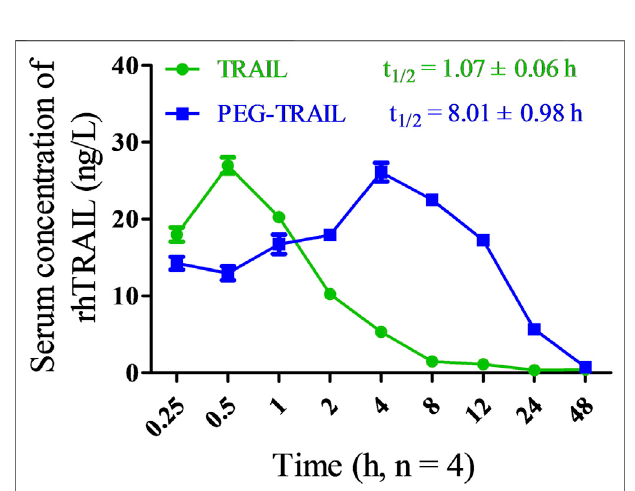
FIGURE 3 | Serum concentrations of rhTRAIL at the designed time points and the corresponding pharmacokinetic parameters (half-life) used in anesthetized